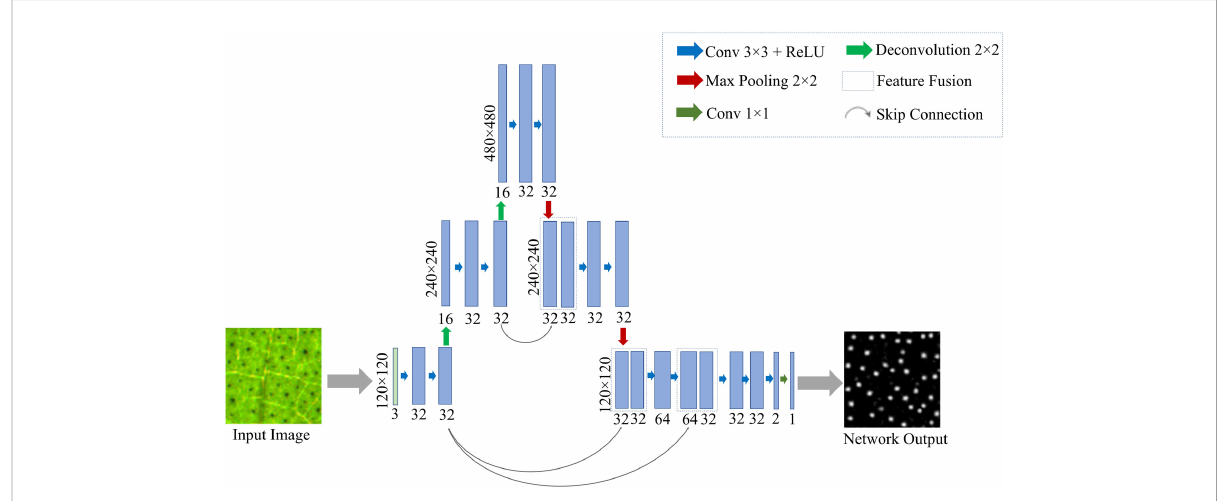
FIGURE 5 Ipp Net model. The structure of up-sampling and down-sampling is adopted, and the up-sampling and down-sampling are performed twice respectively to obtain image